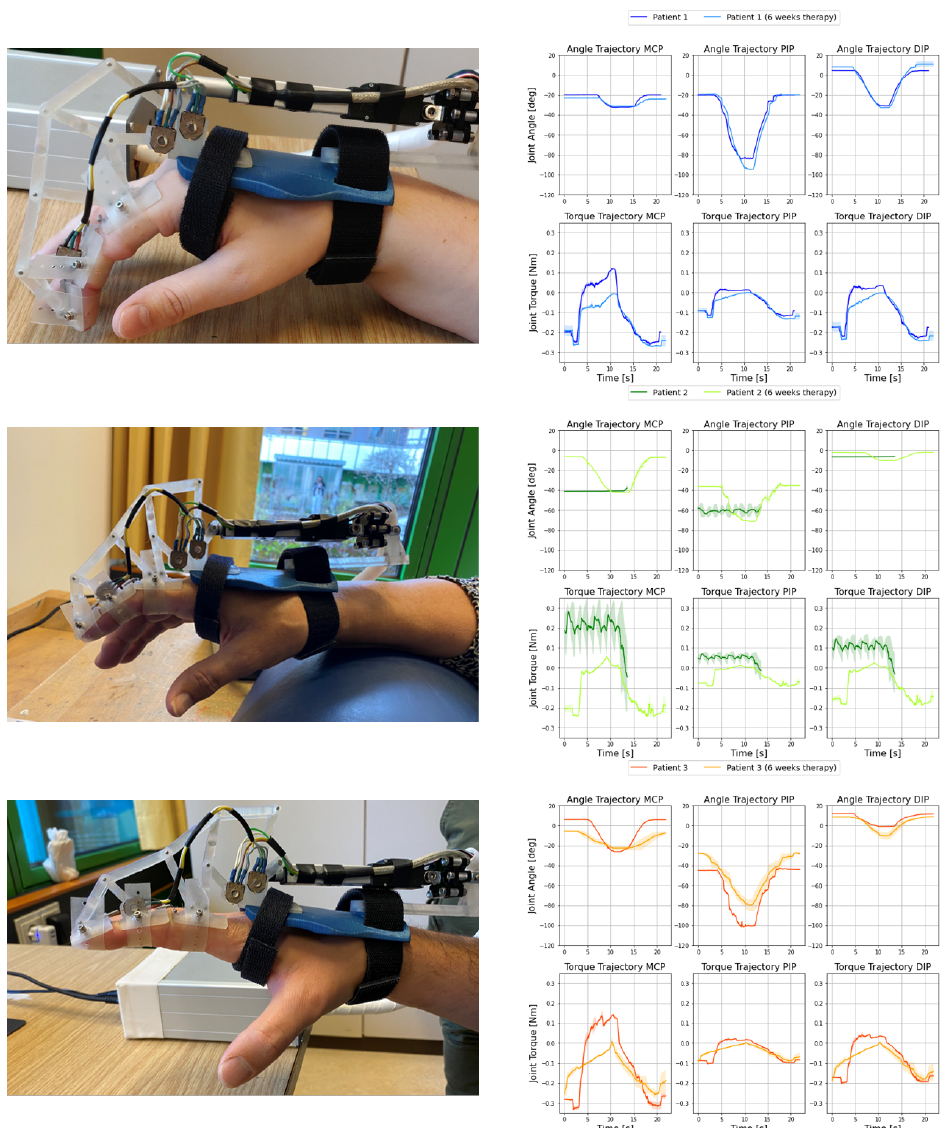
Figure 5. Comparative study of the exoskeleton of patient 1 (blue, top ), patient 2 (green, middle ), and patient 3 (orange, bottom ) over a six-week period. On the left are the patient’s hands wearing the exoskeleton. On the right are the joint curves of the MCP, PIP, and DIP joints (top row) and the corresponding torque curves (bottom row). The measurements shown correspond to the mean (line) ± standard deviation (shaded) of five individual